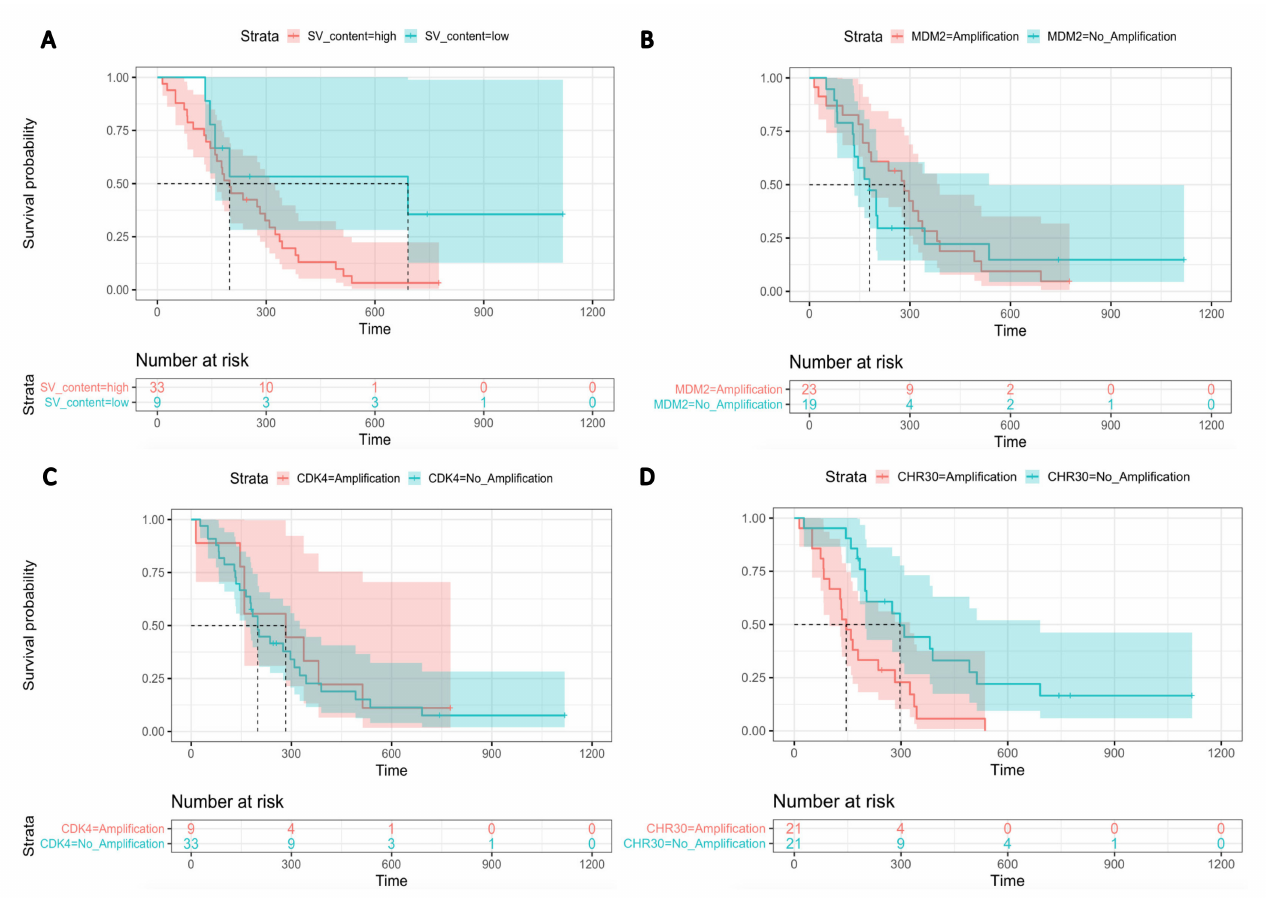
Figure A7. Kaplan Meier Survival Curves for death from MM according to SV profiles ( A ) (one sided log-rank p = 0.025), MDM2 amplification ( B ) (one sided log-rank p = 0.39), CDK4 amplification ( C ) (one sided log-rank p = 0.34) and CHR30 amplification ( D ) (one sided log-rank p = 0.0012).